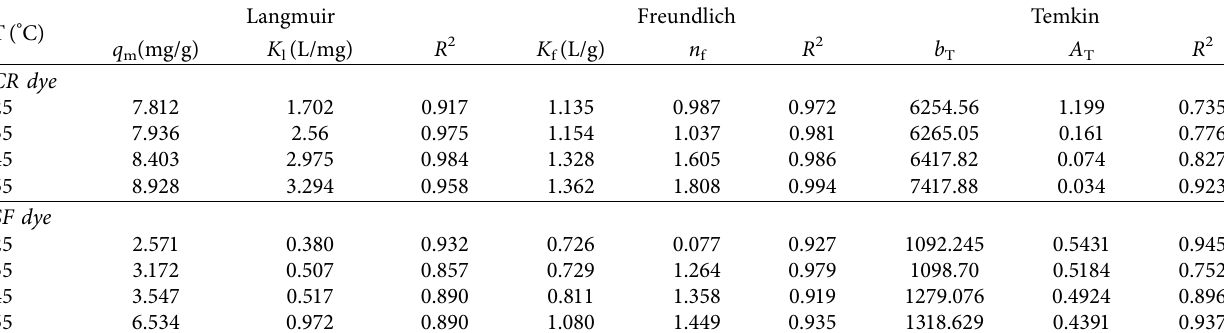
Figure 5: Langmuir isotherm at various temperatures of (a) CR and (b) SF; Freundlich isotherm at various temperatures of (a) CR and (b) SF. Table 1: Isotherm